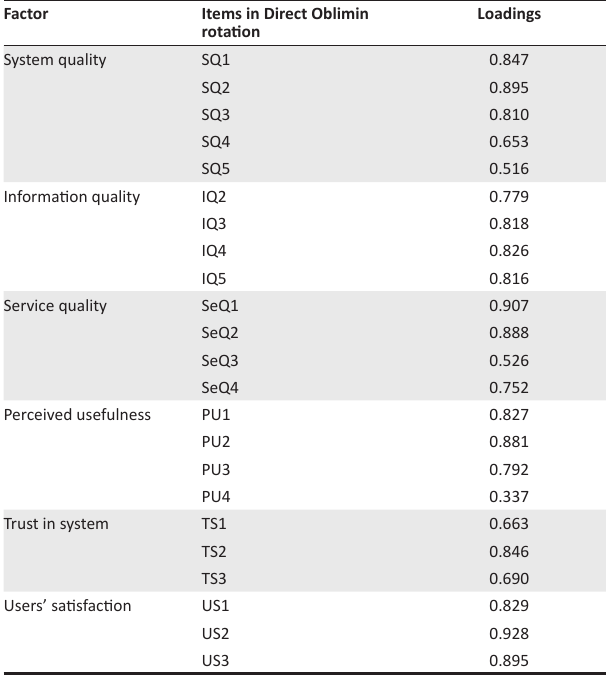
TABLE 3: Factor loadings on the items with Oblimin rotation.